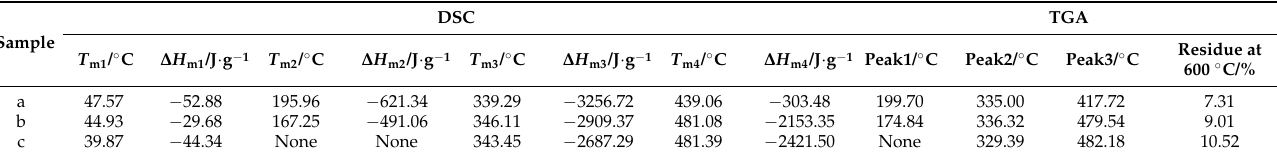
Figure 7. ( a ) DSC curves and ( b ) TGA and TGA derivative curves of the PEO/PVA, HHK/PEO/PVA and AgNP- HHK/PEO/PVA nanofibrous mats. Table 2. DSC and TGA data of the (a) PEO/PVA, (b) HHK/PEO/PVA and (c) AgNP-HHK/PEO/PVA nanofibrous mats.